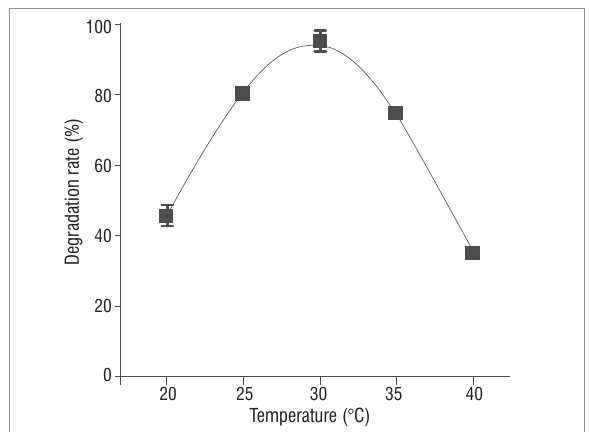
Figure 4: Effect of temperature on the degradation of terephthalic acid by Arthrobacter sp.0574.